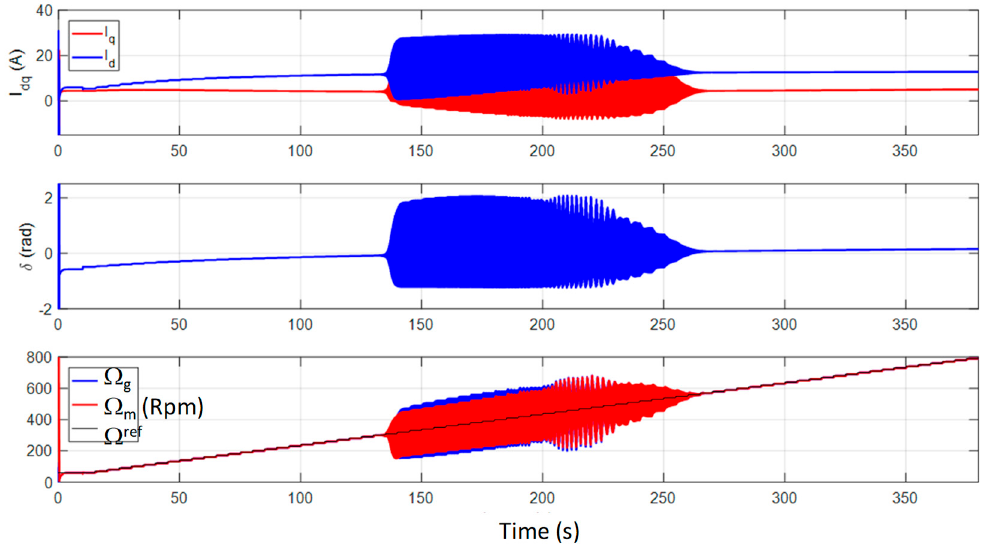
Figure 8. Time simulation with respect to variable stages of the generator speed with a bandwidth of 1 Hz for the generator speed control.